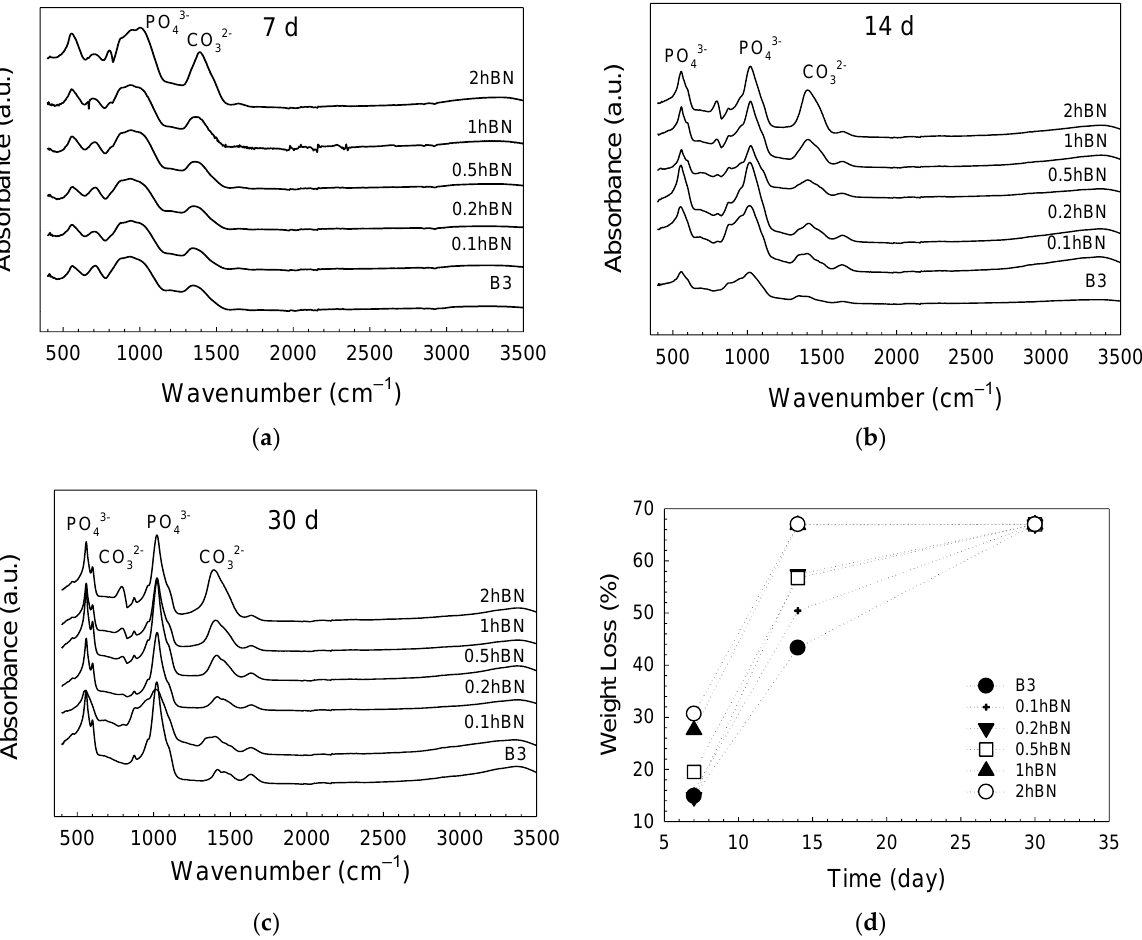
Figure 5. FTIR spectra of the SBF treated bioactive glass scaffolds for ( a ) 7d, ( b ) 14 d, and ( c ) 30 d; ( d ) graph showing the weight loss of the scaffolds as a function of SBF immersion time.